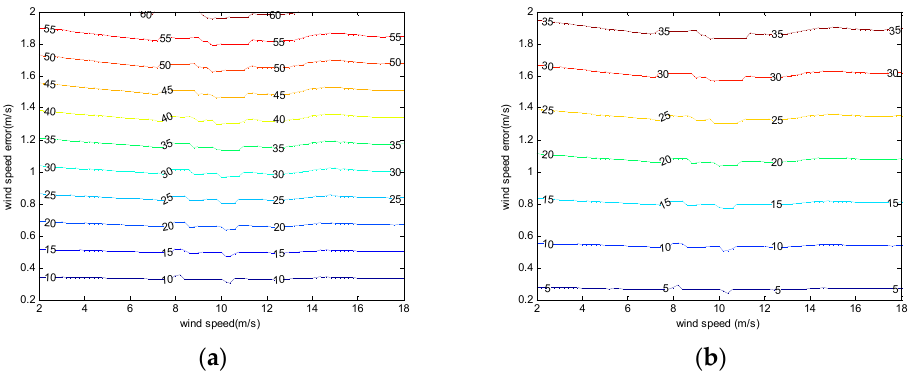
Figure 2. Surface Doppler shift errors due to different wind speed errors in the upwind direction: ( a ) HH polarization; ( b ) VV polarization.